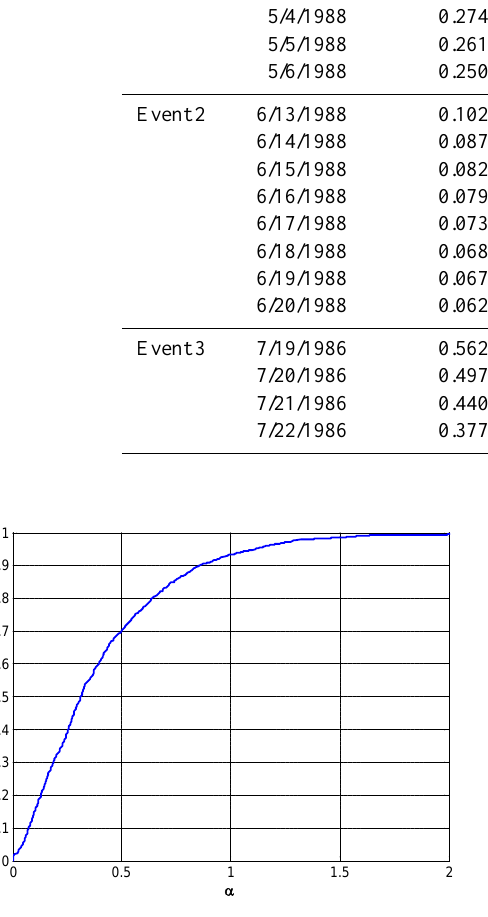
Fig. 7. Cumulative distribution function of β for all of the study watersheds.